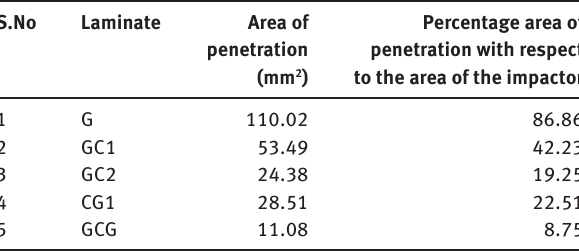
Table 2: Area of penetration for the laminates hybridized with glass and carbon fibers.